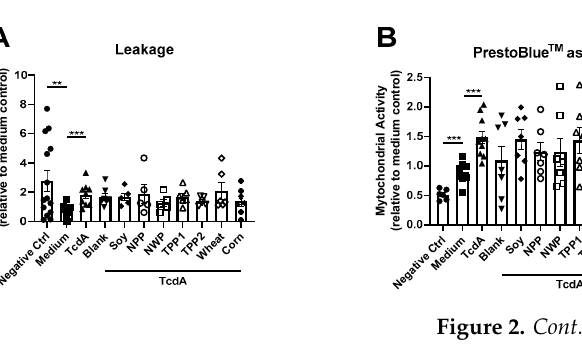
Figure 1. Potency of animal-based dietary protein to restore the effect of clostridium difficile-secreted toxin A (TcdA) on bioengineered intestinal tubules. ( A ) + ( B ) Representative images of bioengineered intestinal tubules ( A ) before and ( B ) after TcdA exposure showing nuclei in blue and zonula occludens-1 in red; ( C – H ) assessment of intestinal parameters after TcdA exposures, including ( C ) inulin-FITC leakage, ( D ) cell viability, ( E ) alkaline phosphatase activity, ( F ) release of IL-6, ( G ) IL-8 and ( H ) NO content. Data are presented as mean ± SD of at least 6 independent experiments and corrected for outliers (excluding 15 out of 424 data points). Control groups (negative control, medium, TcdA and blank) were tested for significance using a Student's t -test. Protein sources were tested for significance using a one-way ANOVA followed by Dunnett’s test (compared to blank), * p < 0.05, ** p < 0.005, *** p < 0.001 and **** p < 0.0001. ND, not detectable.